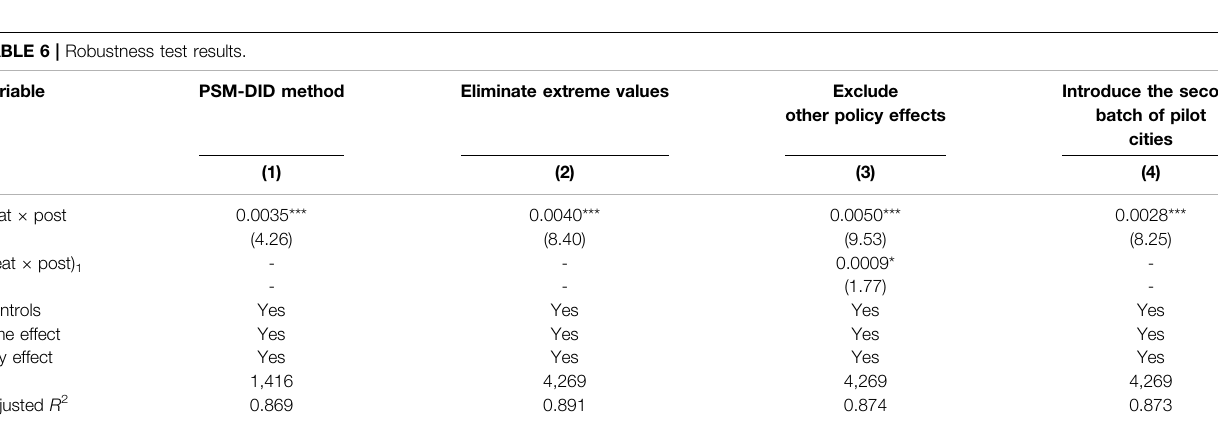
TABLE 6 | Robustness test